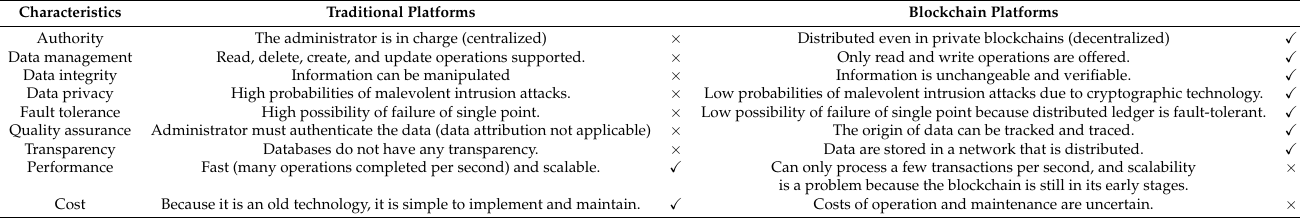
Table 1. A comparison of using a centralized platform against a blockchain platform. Characteristics Traditional Platforms Blockchain Platforms